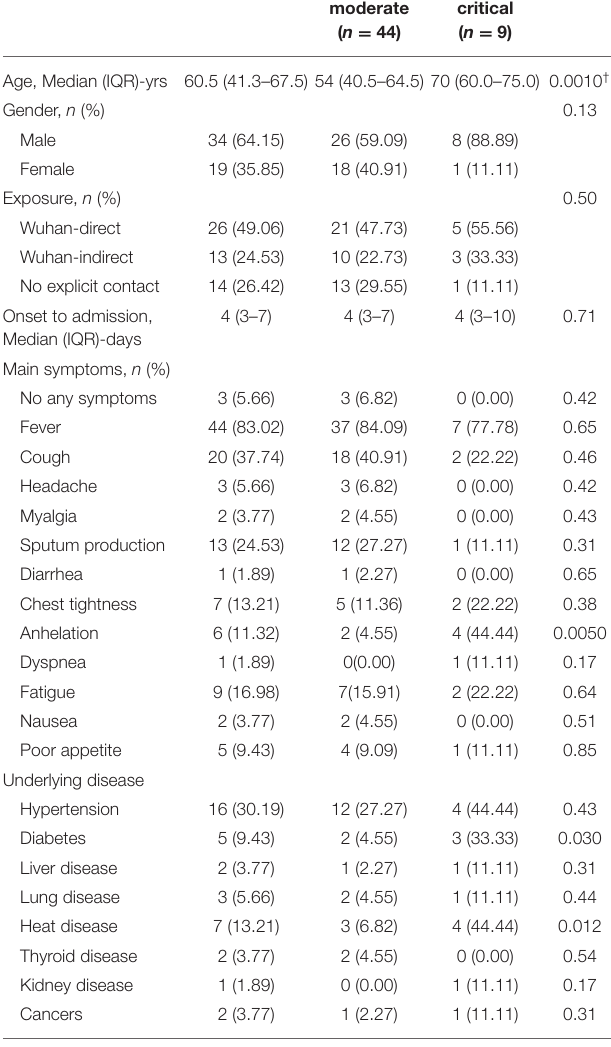
with severe & critical disease using χ 2 -test, Fisher’s exact test, or student t-test. * χ 2 -test or Fisher’s exact test, † Student t-test.